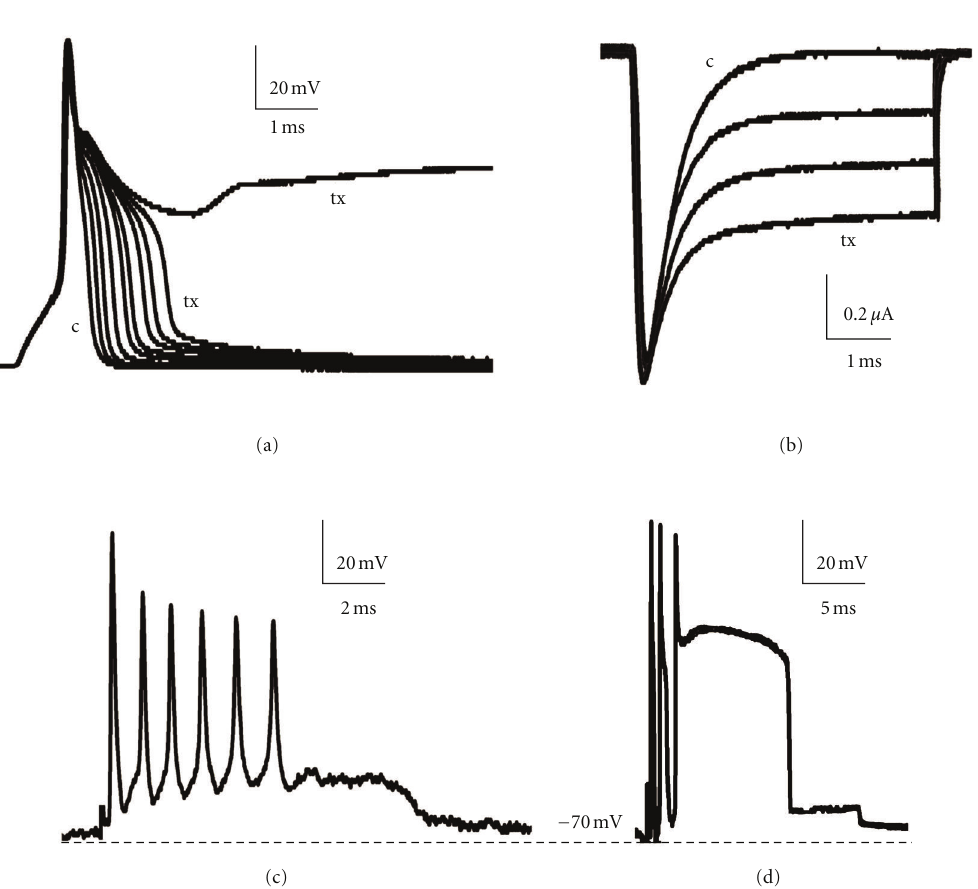
Figure 4: (a) The e ff ect of Lqh α IT (10 − 7 M)—recombinant anti-insect alpha toxin from Leiurus quinquestriatus hebraeus venom on axonal action potential; c—control action potential, tx—progressive increase of action potential duration until plateau action potential under toxin. (b) sodium current prolonged until the end of depolarizing pulse in toxin presence (tx). (c) Repetitive discharges induced by Lqh α IT (5 × 10 − 6 M) recorded from the axon in connective ( in situ ), using microelectrode technique; connective was stimulated by extracellular silver electrodes through an isolated unit. (d) Plateau action potential generated sometimes by axon in situ in toxin